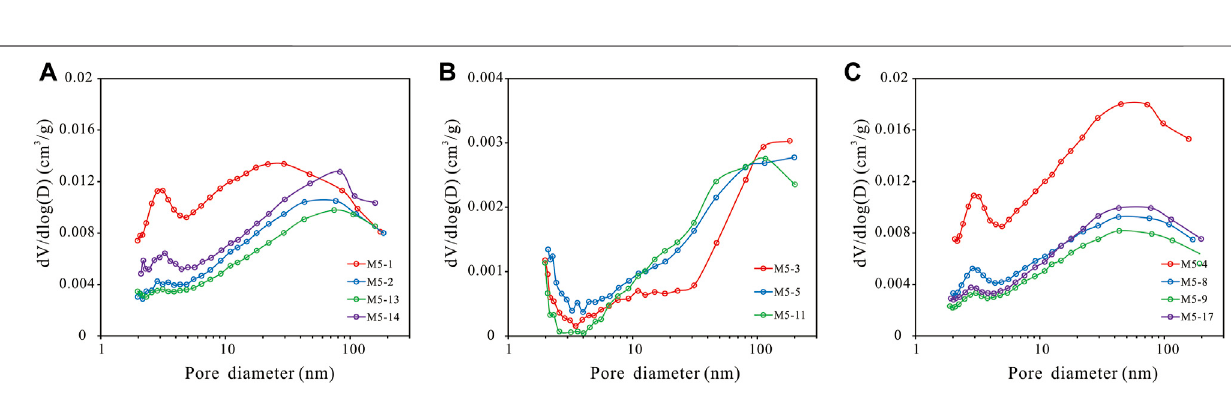
Frontiers in Earth Science |